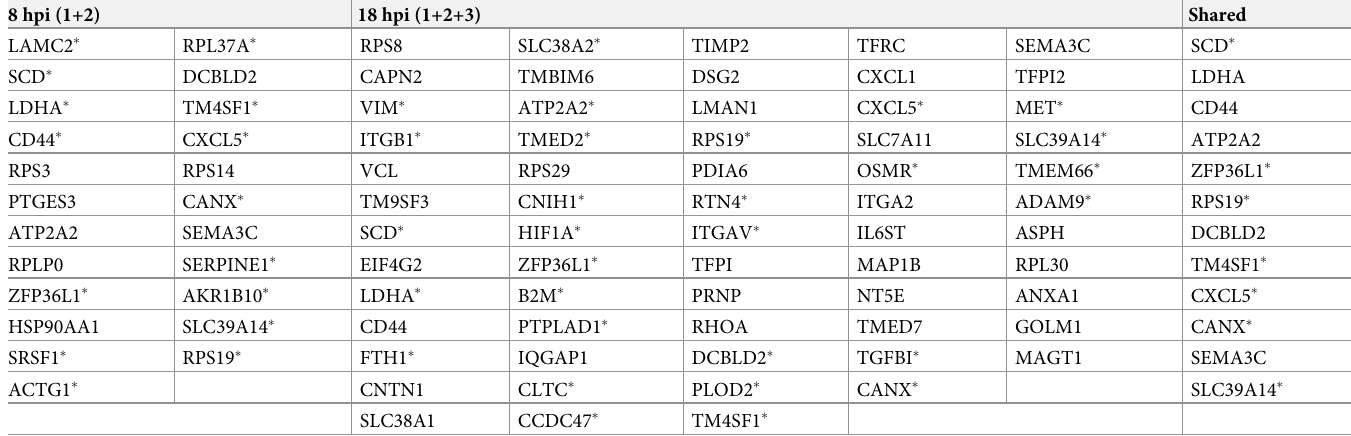
Table 1. Genes identified by CLIPper analysis. The table shows genes that were identified as significant peaks by CLIPper in the two 8 hpi samples, the three 18 hpi sam- ples, or all five samples. Genes with overlapping peak regions in different replicates within either the 8 or 18 hpi grouping are indicated with asterisks. 8 hpi